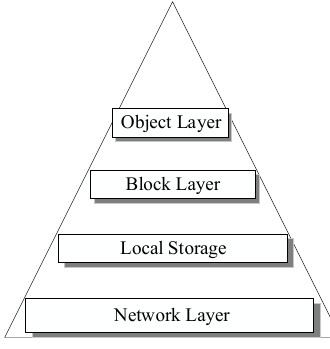
Figure 1. The architecture of decentralized storage